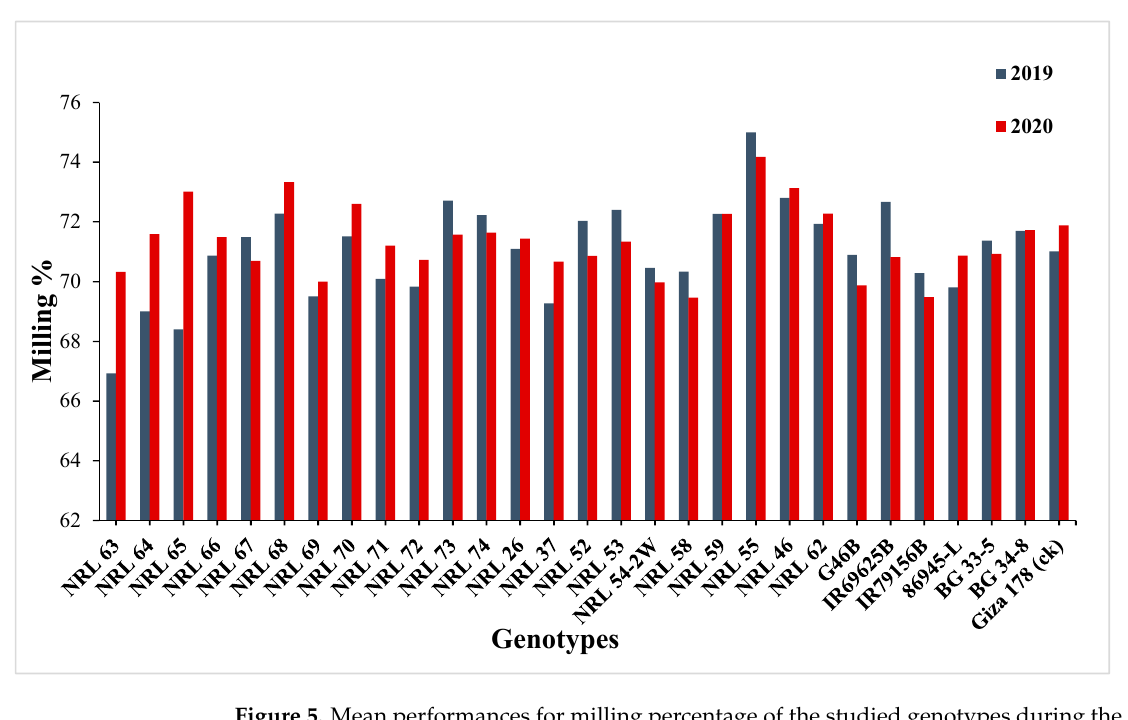
Figure 5. Mean performances for milling percentage of the studied genotypes during the 2019 and 2020 growing seasons.